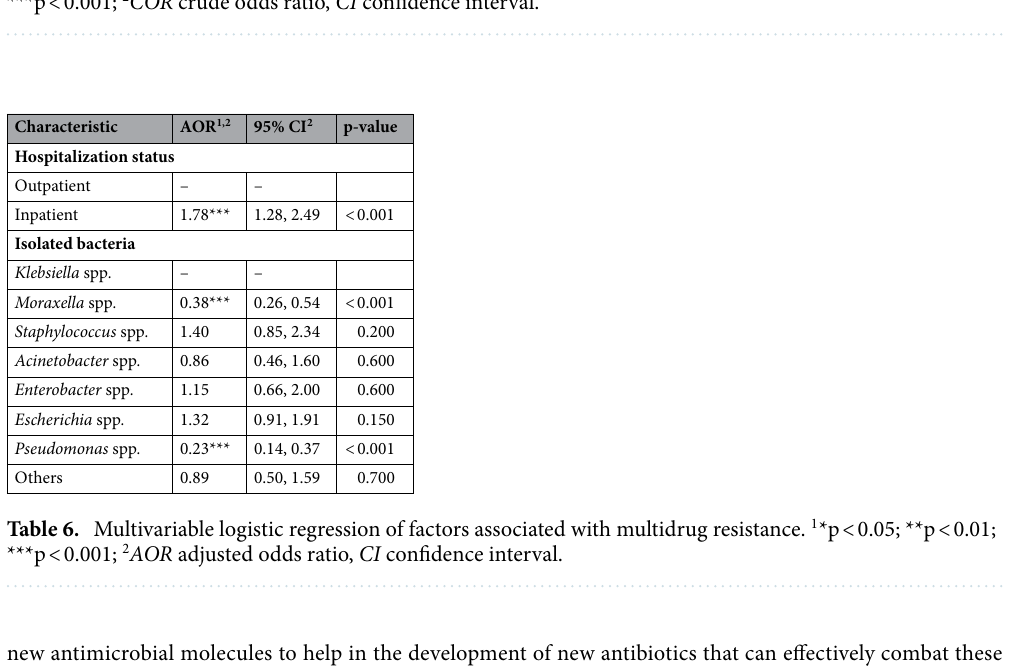
Table 5. Univariate logistic regression of factors associated with multidrug resistance. 1 *p < 0.05; **p < 0.01; ***p < 0.001; 2 COR crude odds ratio, CI confidence interval.